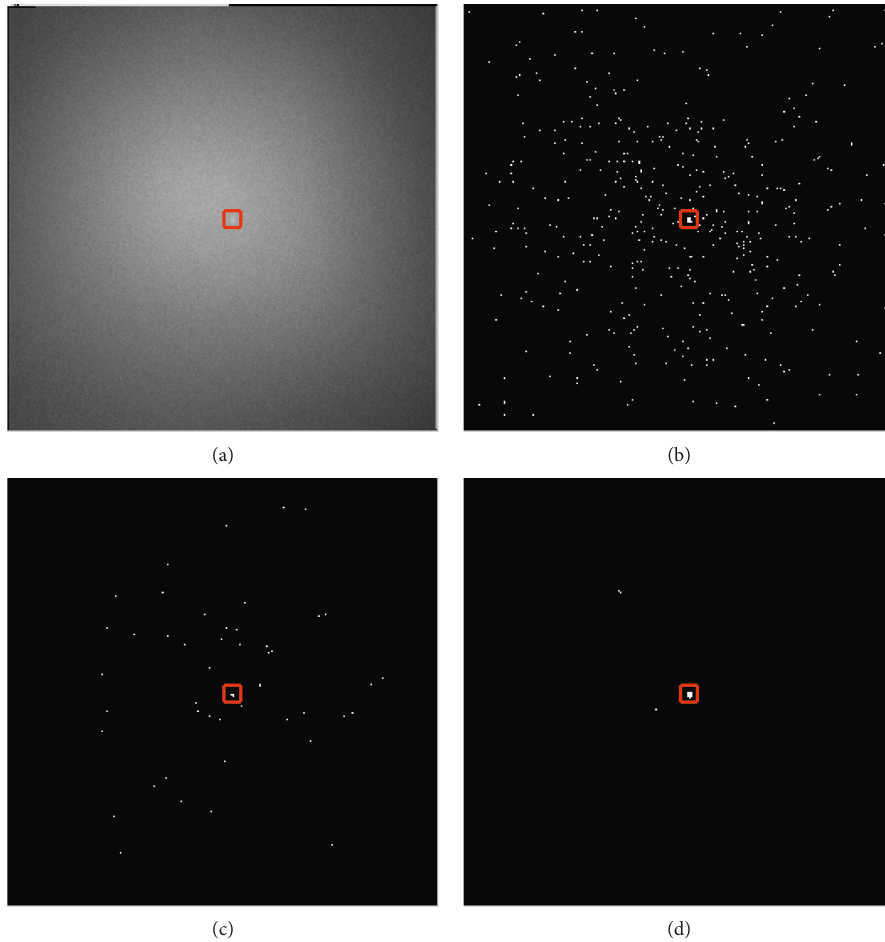
Figure 5: Segmentation results of different algorithms in scene